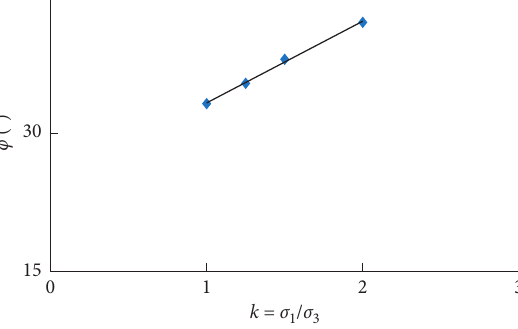
Figure 18: Change law between c and k